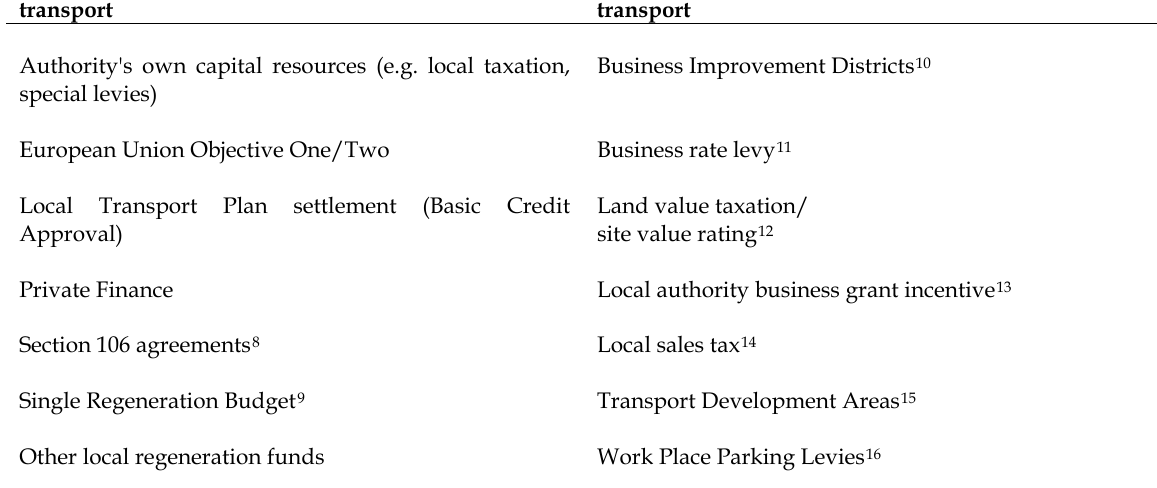
Table 1. Examples of more traditional and more innovative sources of funding Examples of more traditional sources of funding